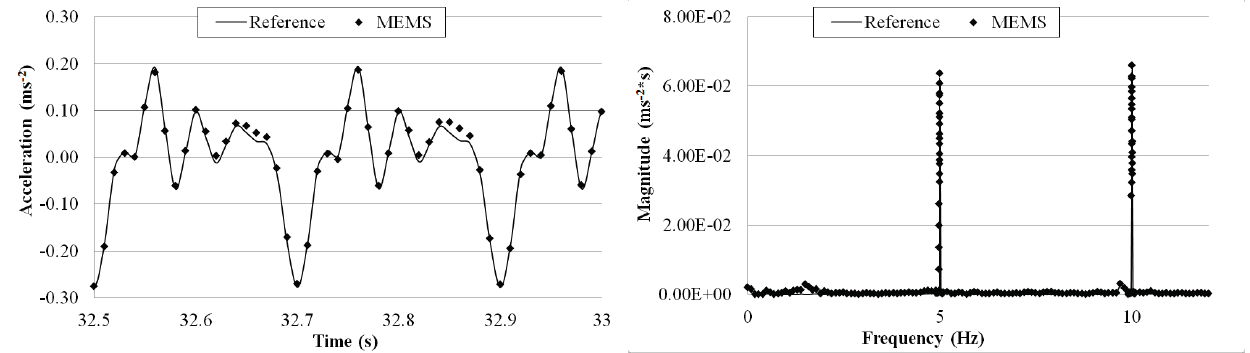
Figure 21. Comparison of measurements by the two sensors in time and frequency domains (5 Hz Periodic Wave Excitation).